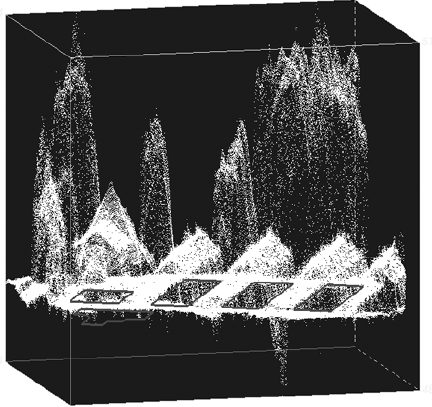
Figure 7. Building model. The building roofs were extracted from a very dense point cloud generated from RCD30 imagery.